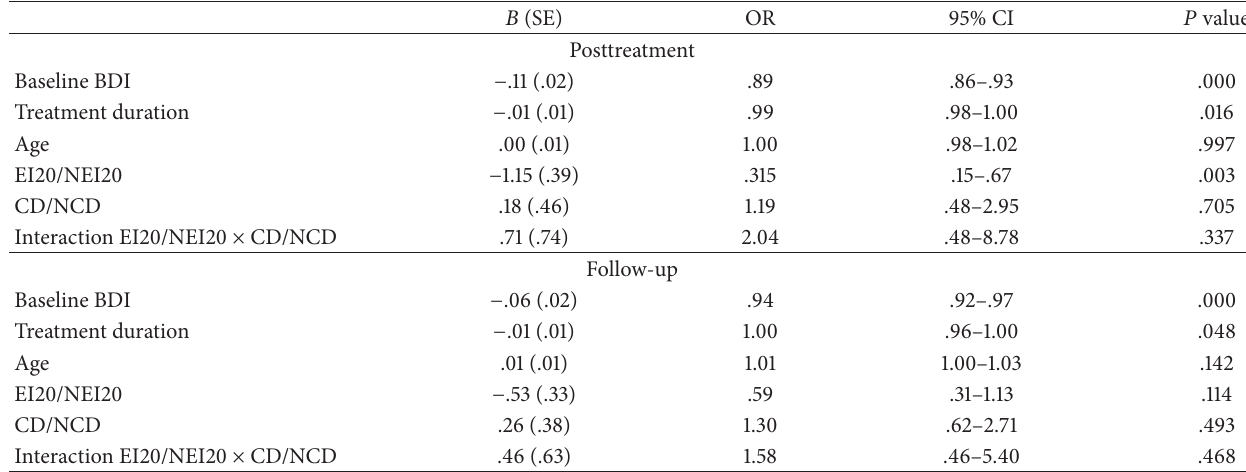
Table 5: Binary logistic regression analyses of the covariates/factors associated with treatment outcome at posttreatment and follow-up for the early improvement definition after 20 days (EI20/NEI20).